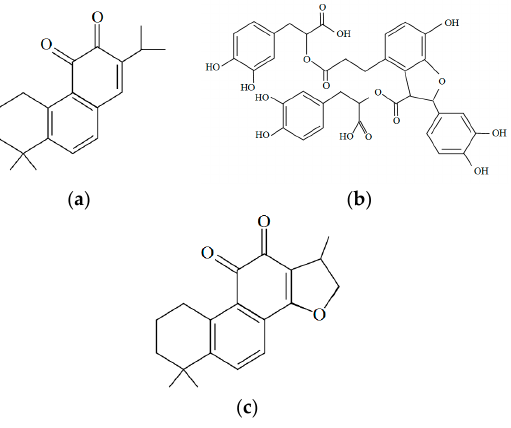
Figure 3. Structures of several bioactive components in Salvia miltiorrhiza : ( a ) Miltirone; ( b ) Salvianolic acid B; ( c ) Cryptotanshinone.